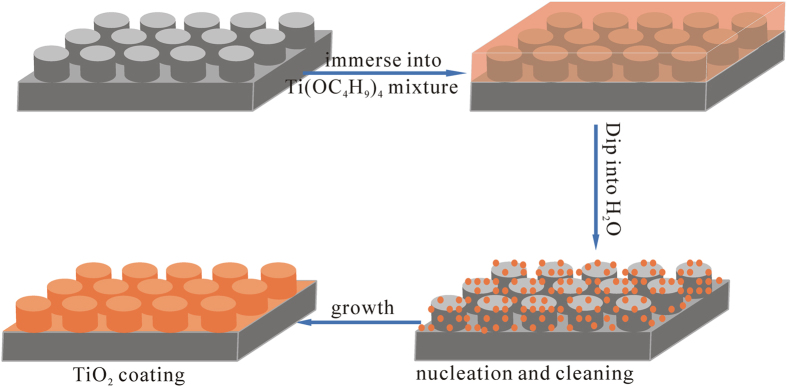
Schematic illustration of the EPLSD process for TiO2 coatings.